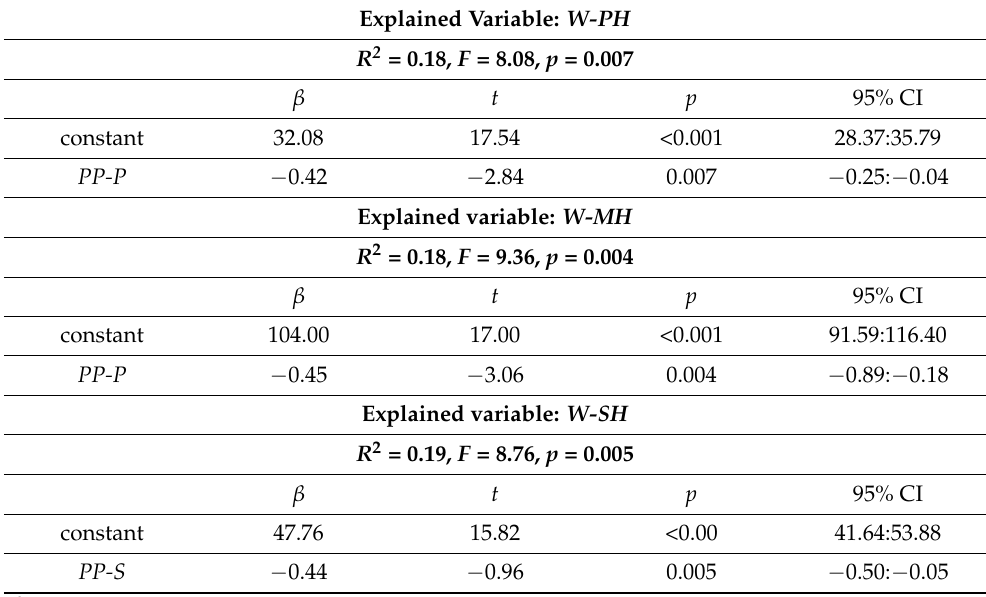
Table 4. Regressions for the perceived function of work for health dimensions—the occupationally inactive